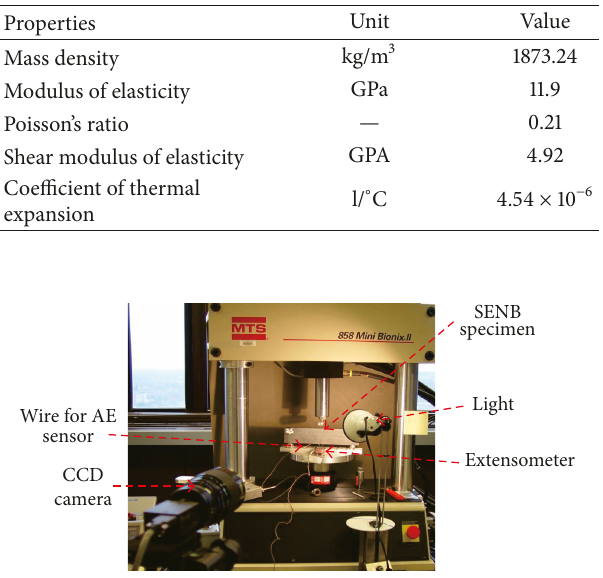
Figure 1: Setup of the three-point-bend test with a specimen in